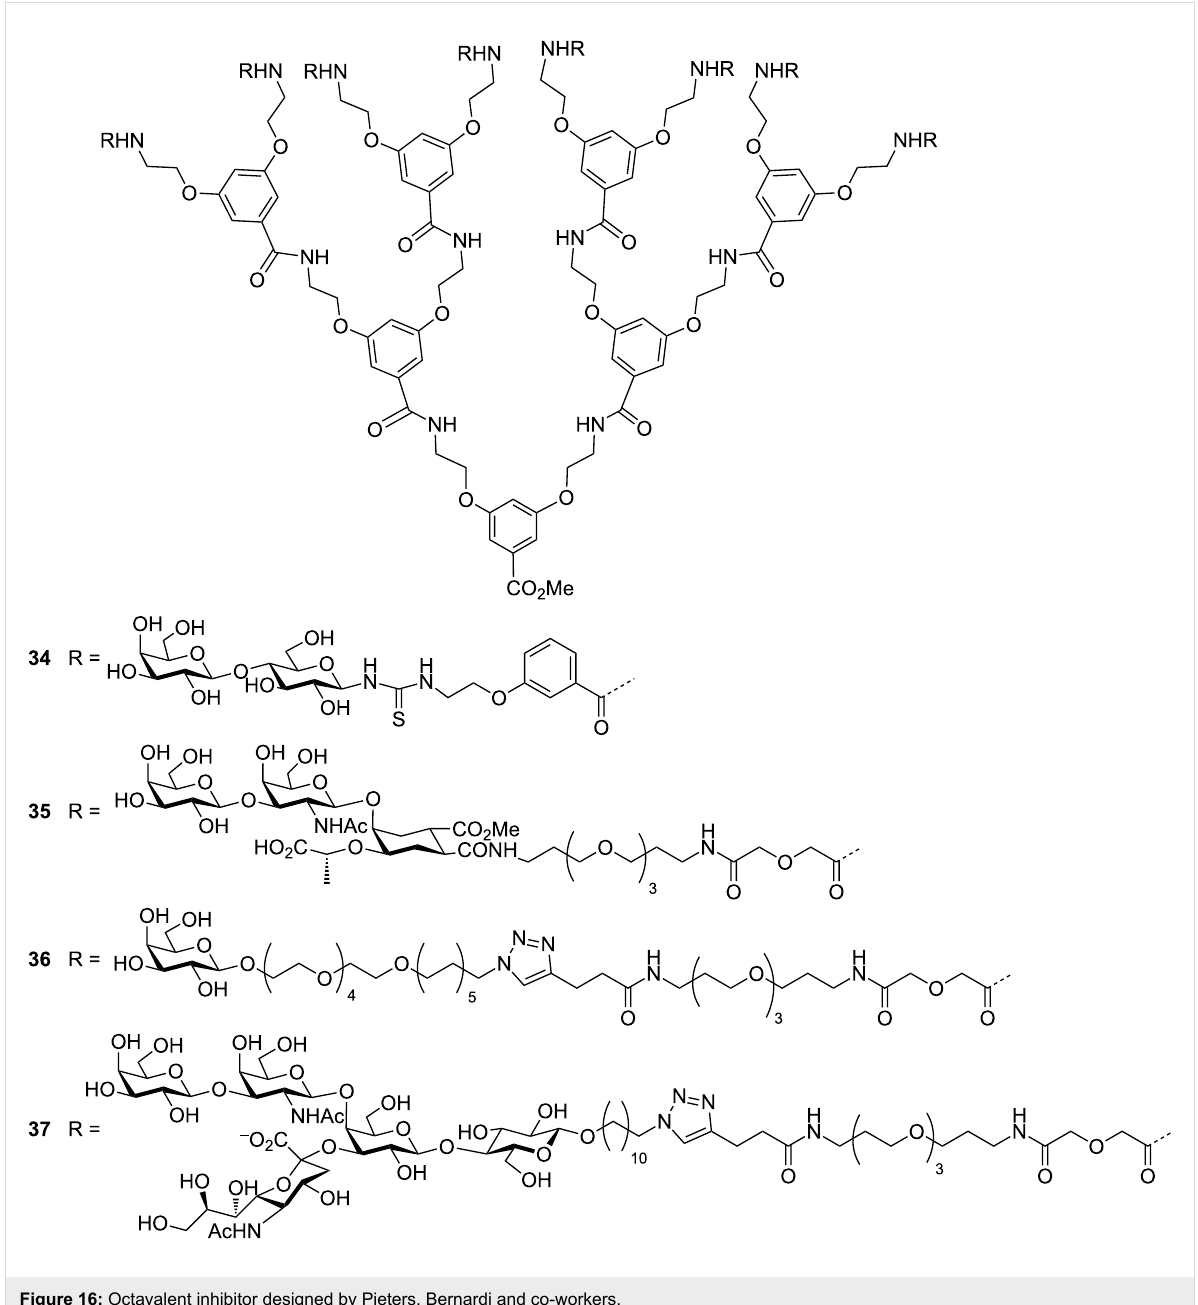
Figure 16: Octavalent inhibitor designed by Pieters, Bernardi and co-workers.